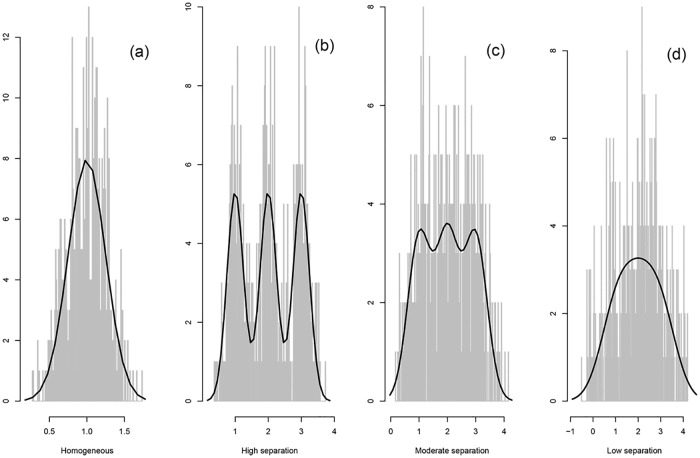
Univariate simulated data study.Histograms of randomly selected generated data sets. The solid lines represent the true marginal densities.